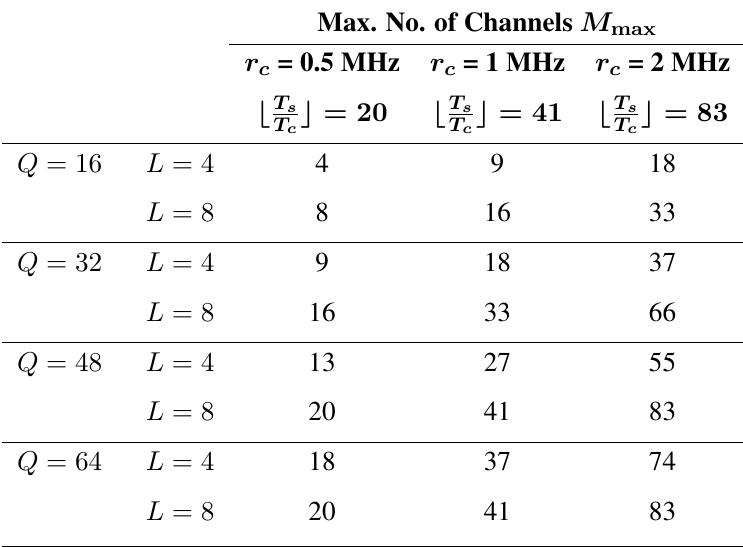
for various combinations of Q , L and r max